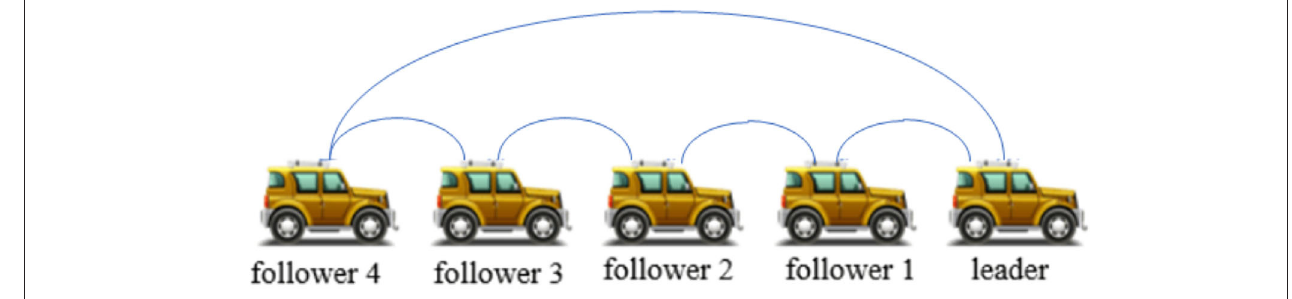
FIGURE 2 | Topology at initial time.